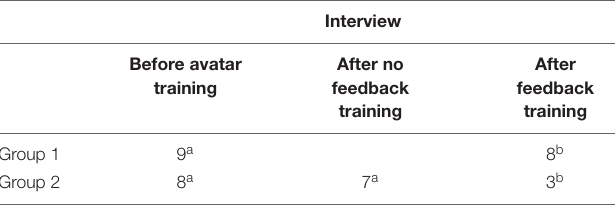
Shaded numbers indicate interviews conducted before avatar training with feedback. In subsequent statistical analyses of the transfer effect, the interviews with suprascript a were compared to interviews with suprascript b